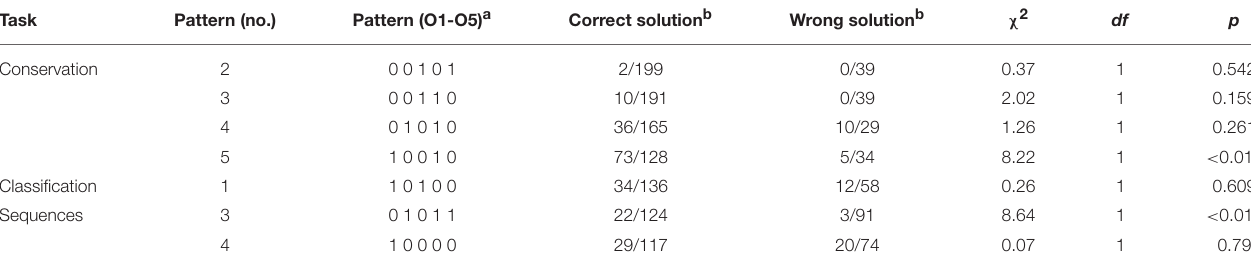
TABLE 3 | Association of identified patterns of mental operations (strategies) and correct solution. Task Pattern